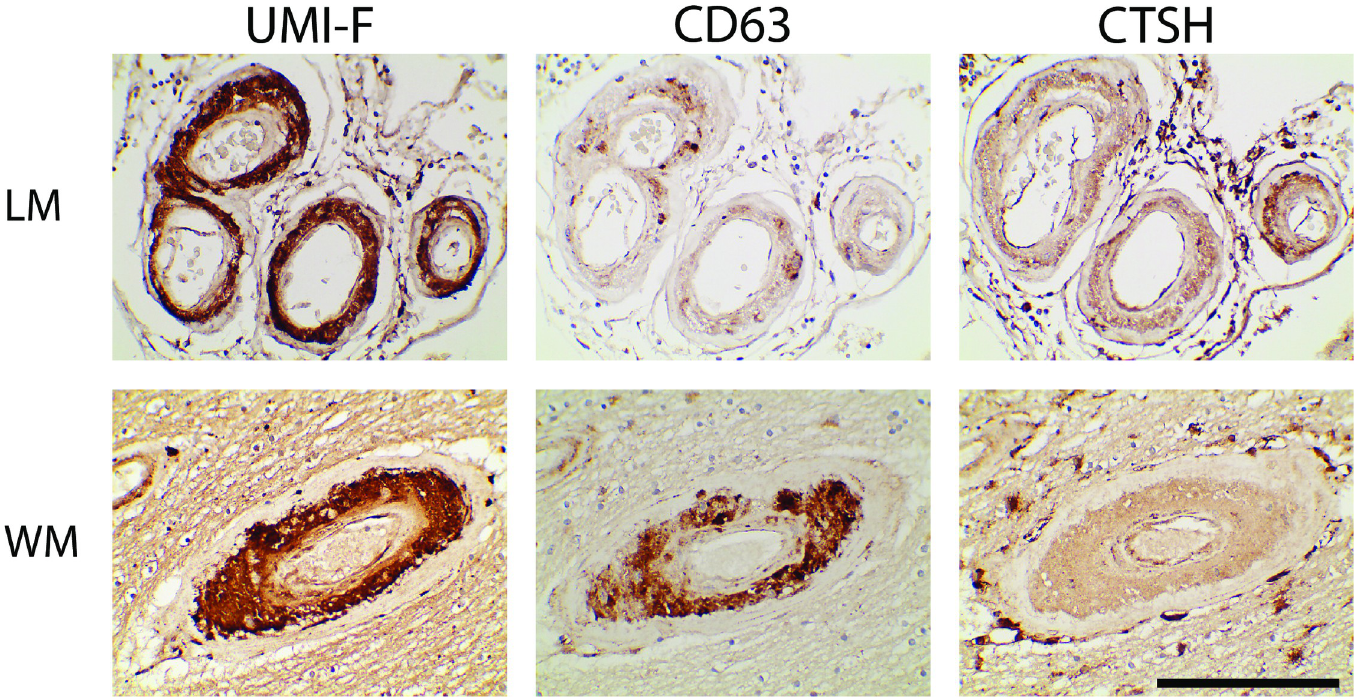
Fig 6. Localization of CD63 and CTSH in CADASIL cerebral arteries. Immunohistochemical localization was performed for the N-terminal fragment (NTF; recognized by UMI-F), CD63 (H5C6), and CTSH on serial sections of CADASIL frontal lobe. Both leptomeningeal (LM) and white matter (WM) arteries showed medial staining which exceeded levels in the adventitia and intima. Scale bar shows 100